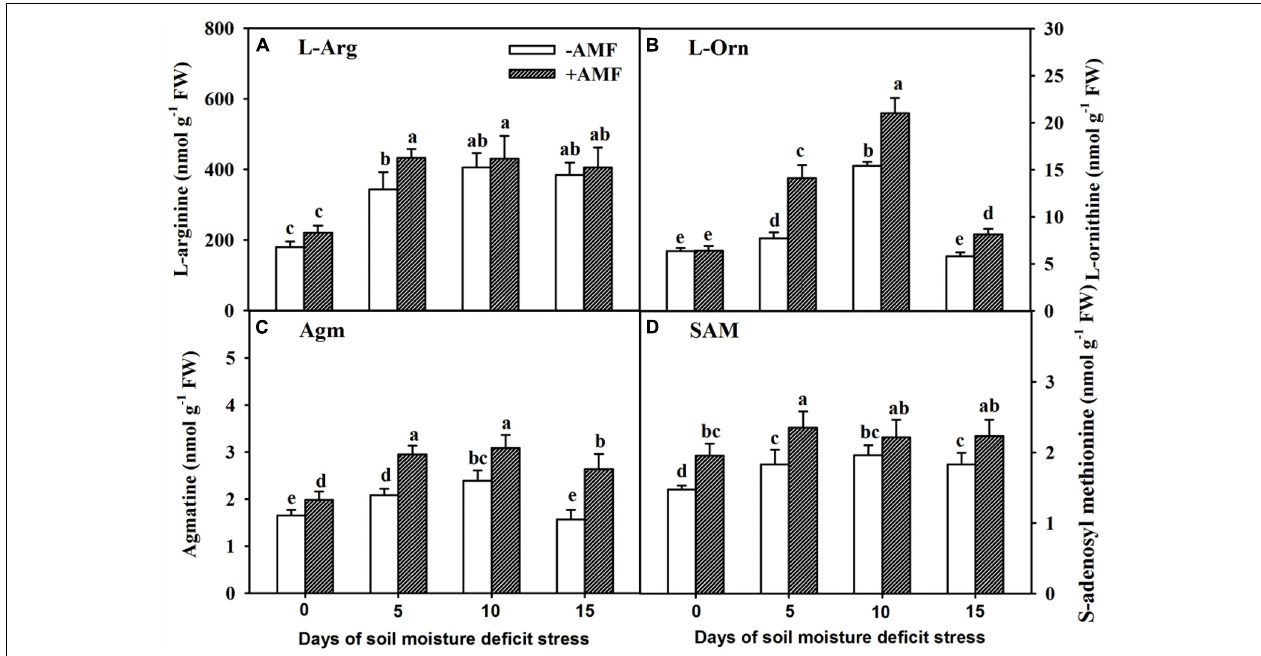
FIGURE 4 | Concentrations of root L -arginine ( L -Arg) (A) , L -ornithine ( L -Orn) (B) , agmatine (Agm) (C) , and S -adenosyl methionine (SAM) (D) of trifoliate orange seedlings inoculated with and without Funneliformis mosseae during exposure to soil moisture deficit stress (SMDS) of 0-15 days. Data (mean ± SD, n = 4) followed by different letters above the bars indicate significant ( P < 0.05)